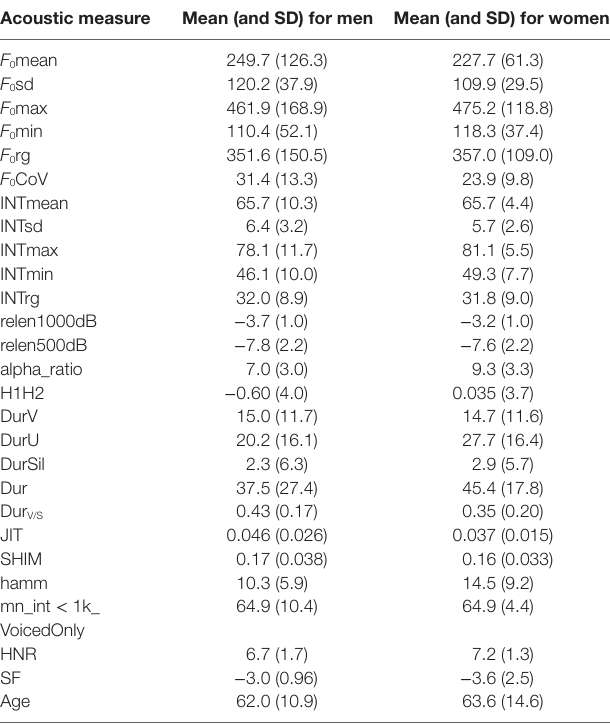
Table 2 | Mean and SD for each acoustic measure across sexes. acoustic